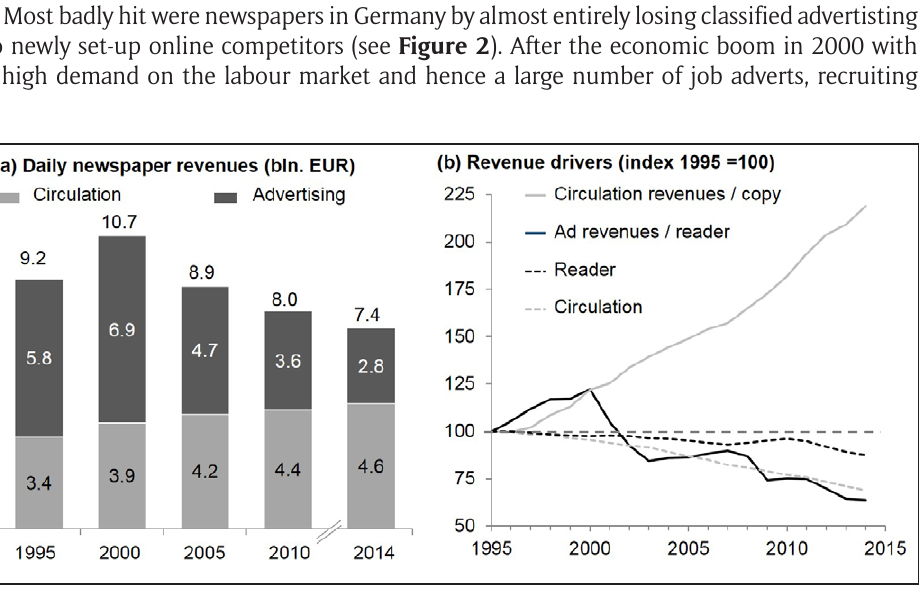
Figure 1: Revenues and revenue drivers of German daily newspapers. Source : Own calculations on the basis of raw data from BDZV (2015), IVW